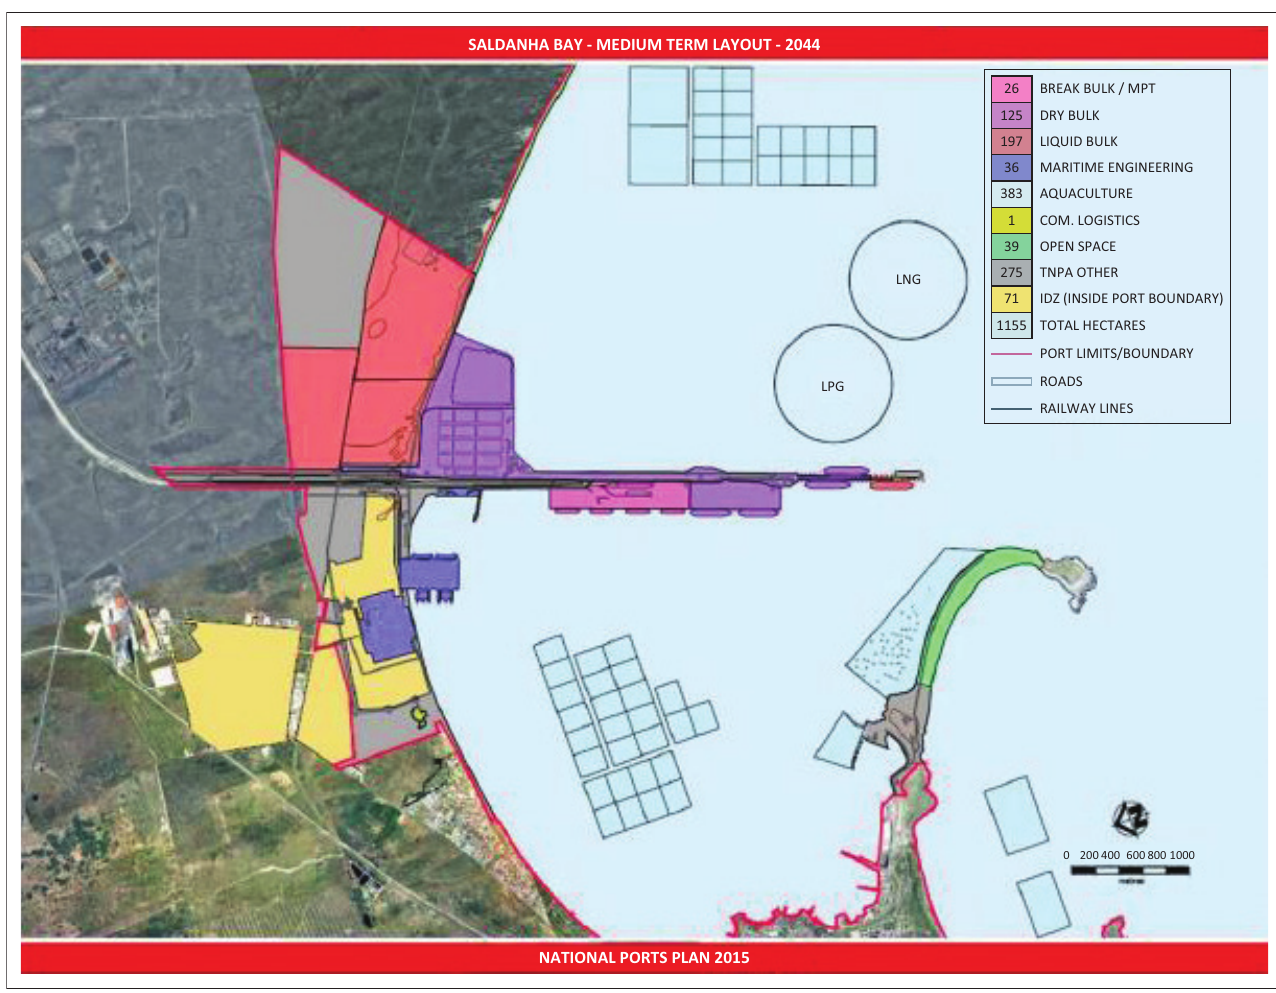
FIGURE 3: Transnet National Port Authority projected development in